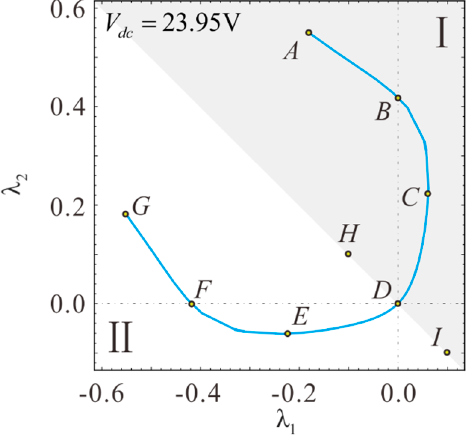
λ and Figure 9. The relationship between λ 1 and λ 2 under linear vibration when V dc = 23.95 V. Figure 9. The relationship between 1 Table 1. Section parameter corresponding to nine special points.